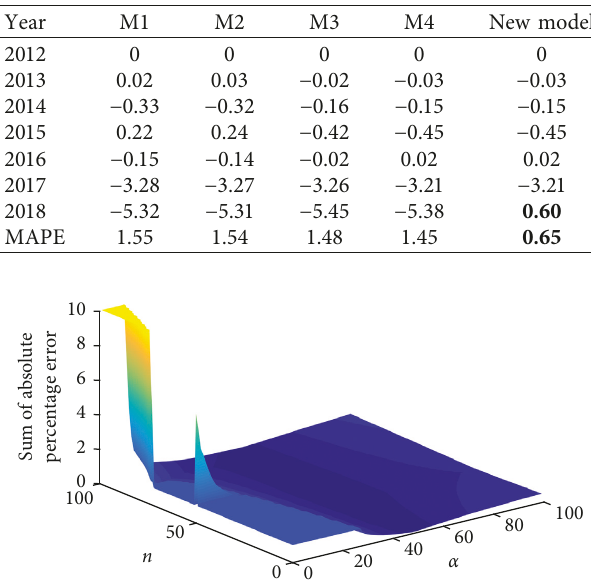
Figure 2: The track of simultaneously seeking the parameters n and α in optoelectronic application.